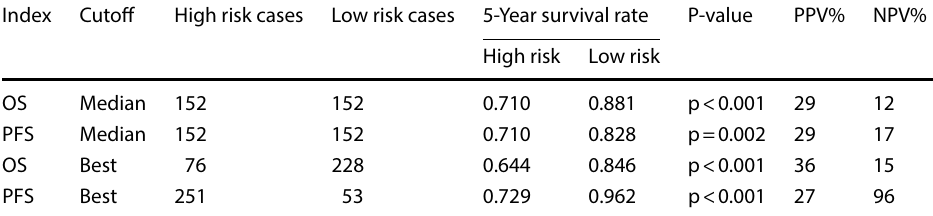
Table 2 Clinical significance of the 9-IRRGs signature- based risk score in predicting prognosis of patients in cervical cancer